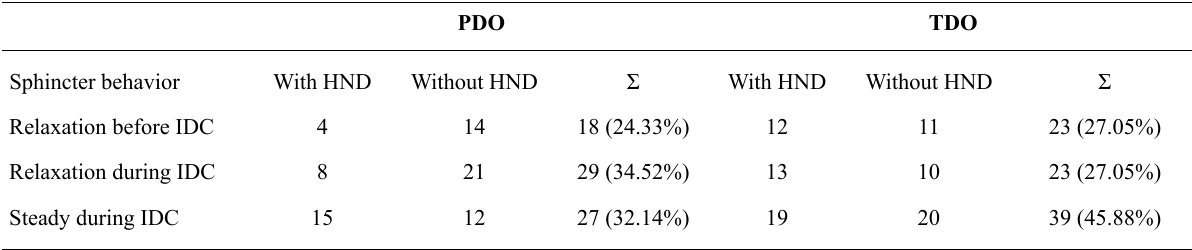
Table 7 - Relationship between sphincter behavior and a history of neurological disease (HND) at IDC in each DO group. Sphincter relaxation before or during IDC is significantly observed in PDO women without HND (p =